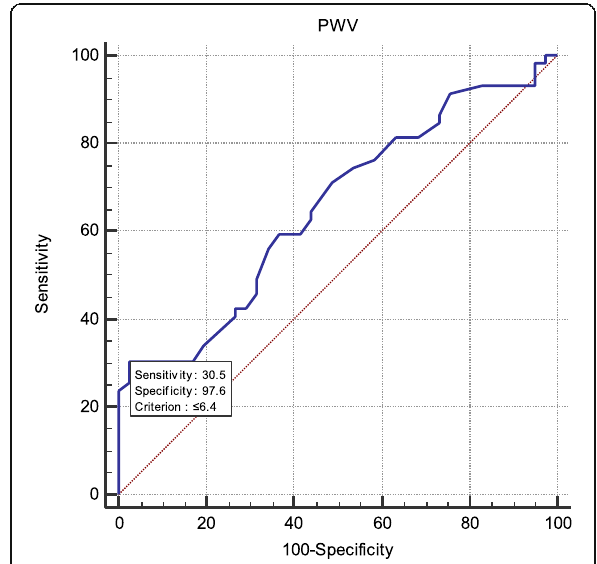
Fig. 1 High sensitivity of ABPM DBP with CIMT (92.9%)